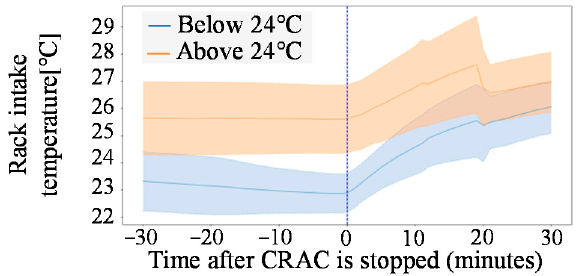
Figure 11. Time-series changes of rack intake temperature classified as above or below 24 °C. (line: average value, over line: mean + standard deviation (SD), under line: mean − SD).